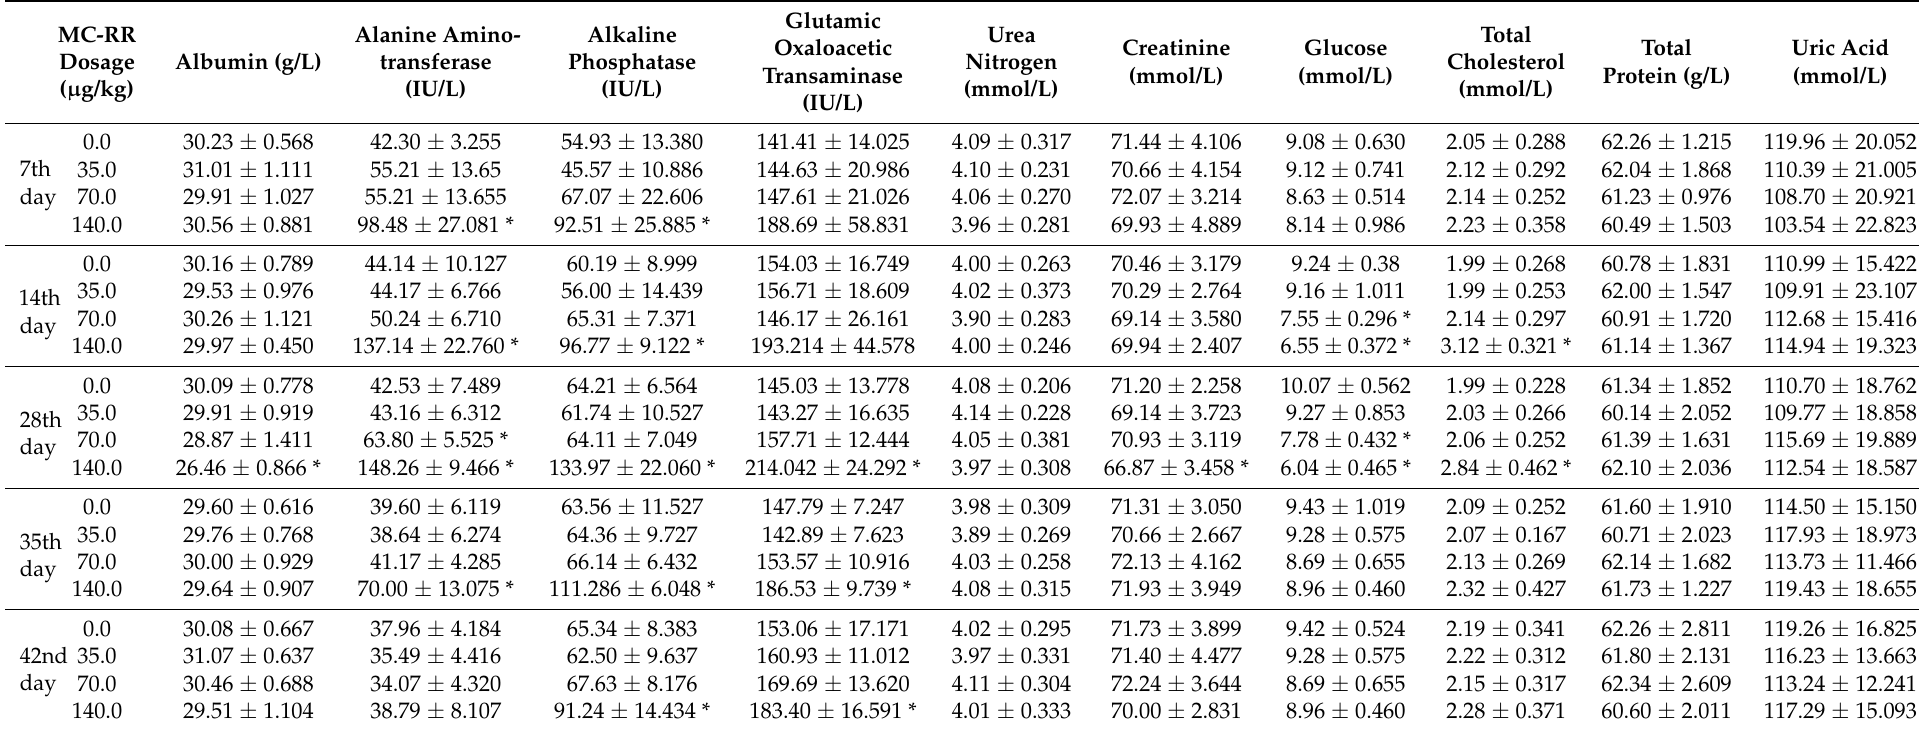
Table 6. Serum biochemical analysis of KM mice treated with MC-RR in continuous exposure experiment (mean ± SD, n =